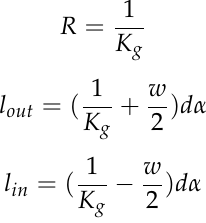
Figure 2. Linear placement and lateral bending of prepreg tow.